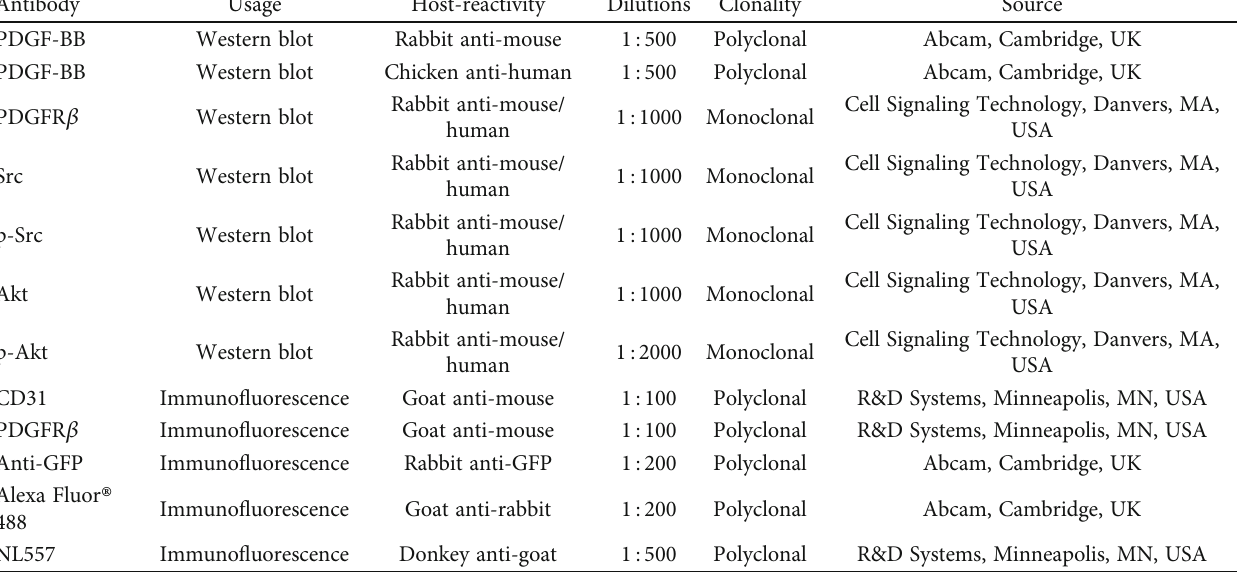
Table 3: Antibody